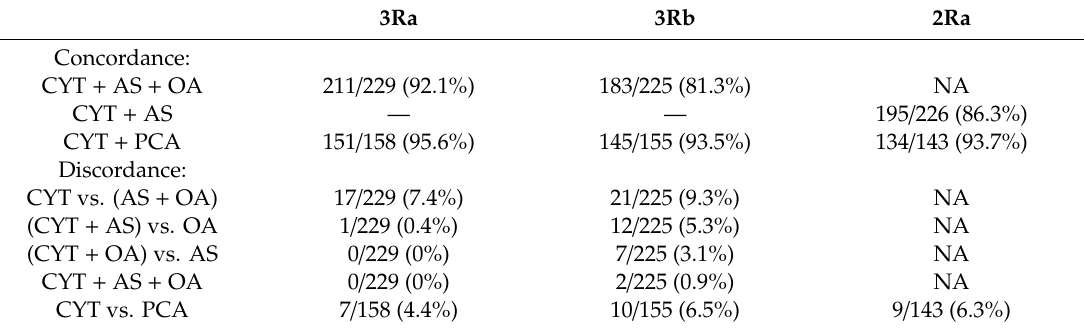
Figure 3. Concordance heat map of genotypes imputed by cytogenetics (CYT), OpenArray (OA), and amplicon sequencing (AS). Each row is an individual mosquito, and the columns (inversions 3Ra and 3Rb) report the degree of agreement among genotyping approaches for the inversions in each mosquito. Dark green represents 3-way genotypic concordance; light green, concordance between AS and OA; blue, concordance between CYT and AS; yellow, concordance between CYT and OA; red, 3- way discordance; black, missing data for at least one genotyping approach.